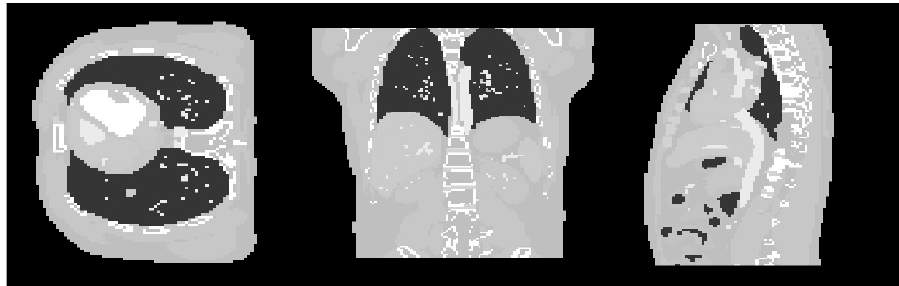
Figure 2. Cross-sectional slices of the XCAT phantom used for the training of parameter in the three axes.